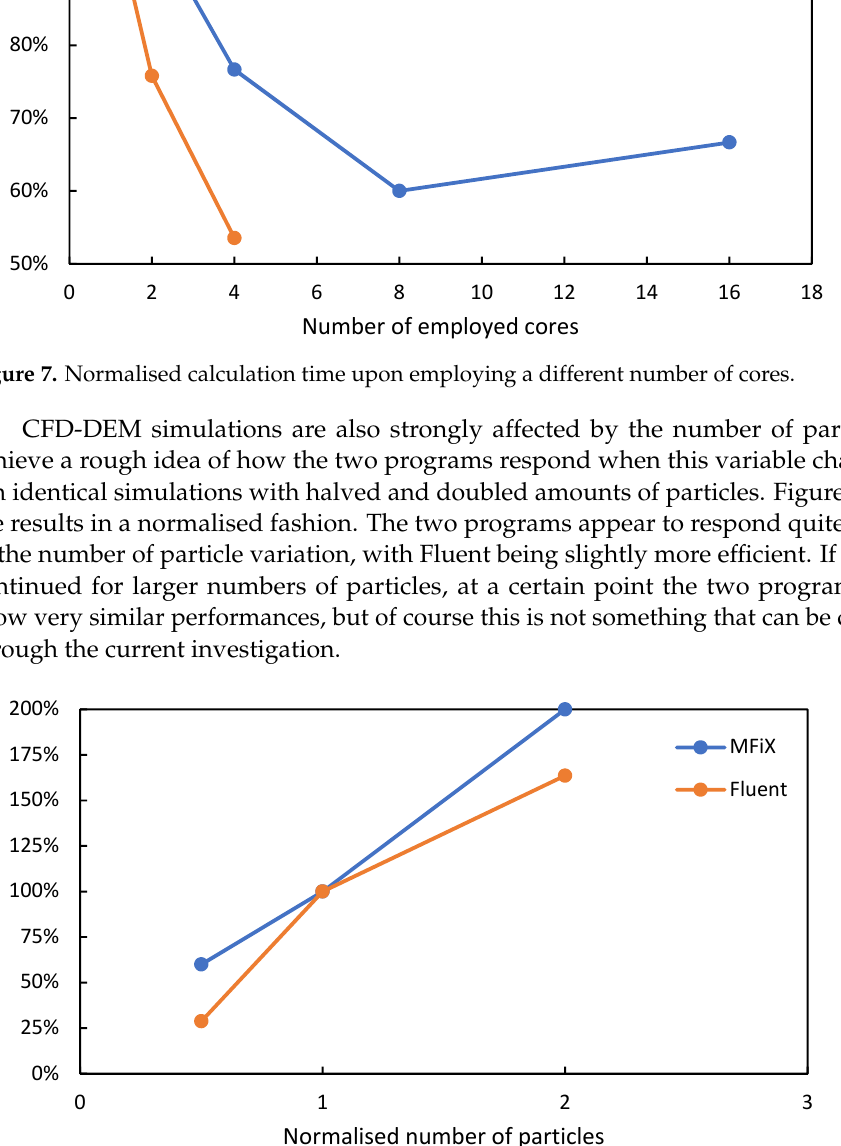
Table 3. Point-by-point comparison of Ansys Fluent and MFiX applied to CFD-DEM. Ansys Fluent MFiX Cost